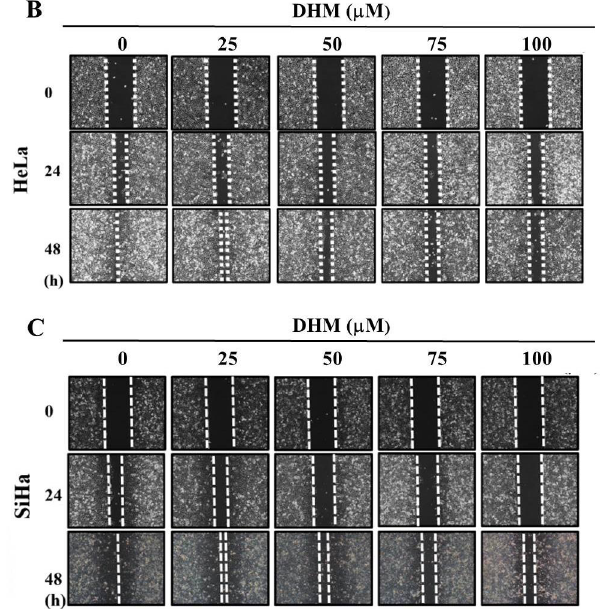
Figure 1. Effects of DHM on cell viability and wound healing assay in cervical cancer cell lines. ( A ) HeLa and SiHa cells were seeded onto 24- well plates and treated with DHM (0, 25, 50, 75, 100 μM) for 24 h and assessed for cell viability. ( B ) HeLa and ( C ) SiHa cells were treated onto 6-well plates and a line was drawn between cells and cells, then observed for the ability of healing in 24 h and 48 h on various DHM concentrations by microscope. Cells were photographed using microscope (100×).